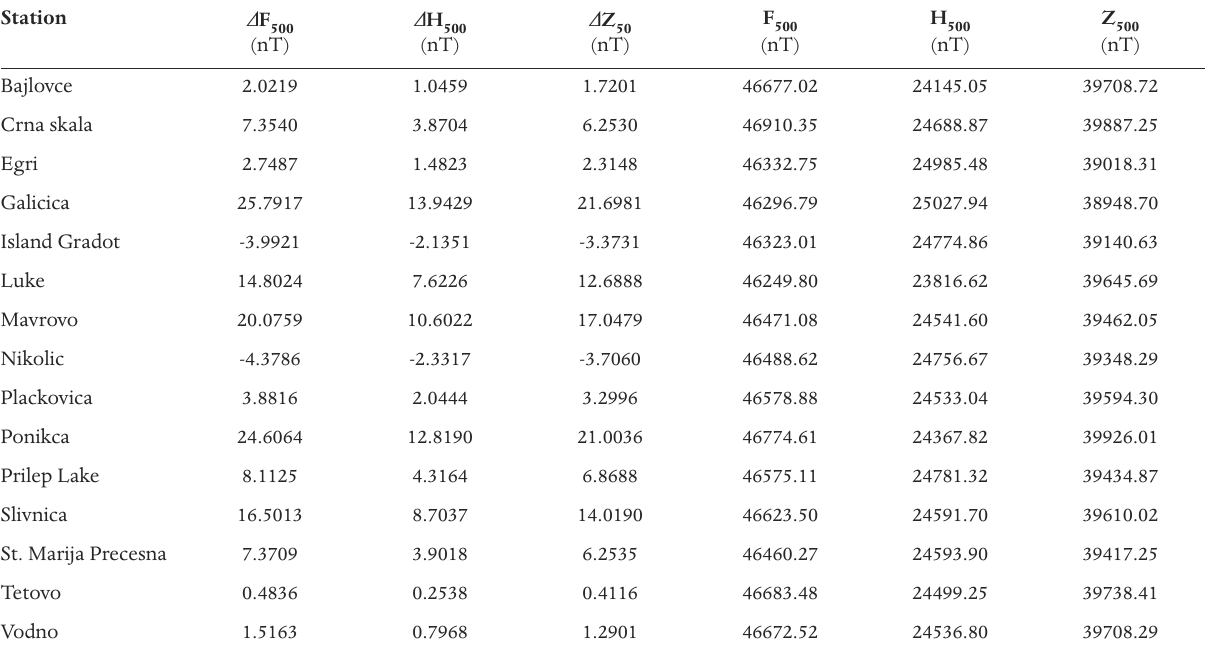
Table 3. Corrections and reduced values for the intensive field elements at h = 500 m